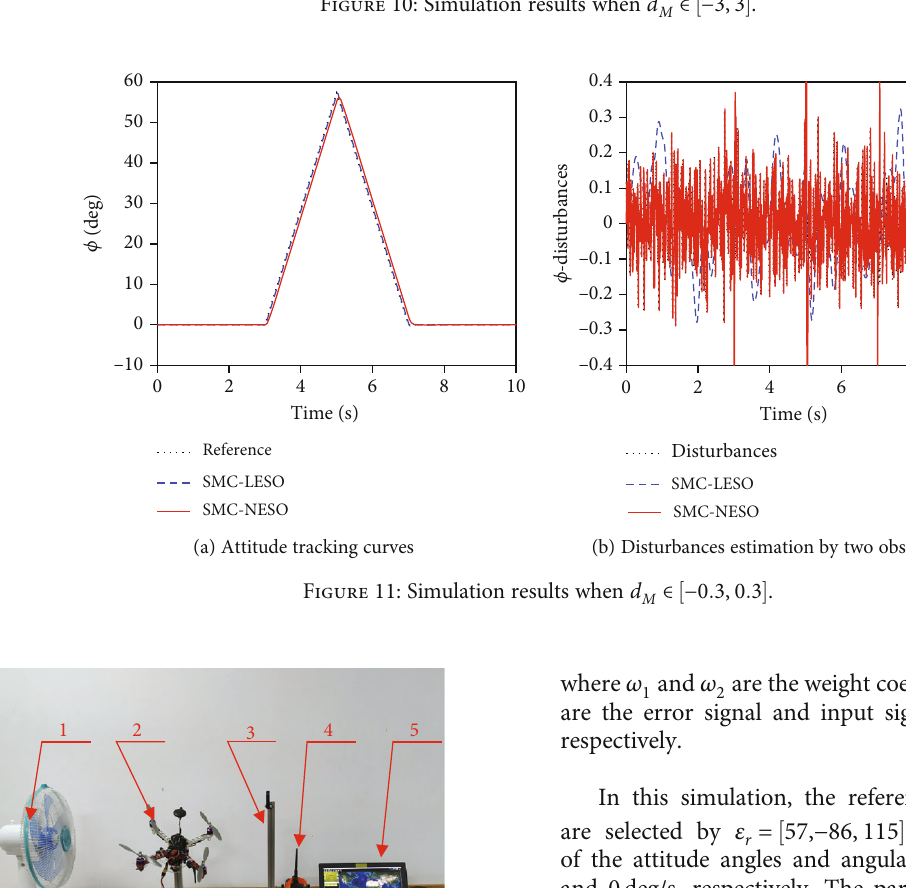
Figure 10: Simulation results when d